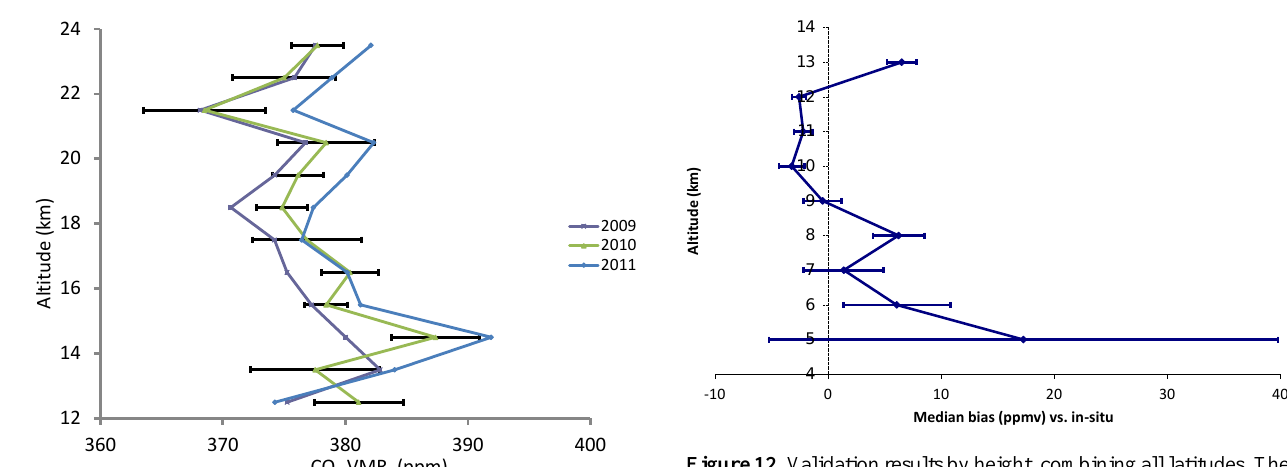
Figure 12. Validation results by height, combining all latitudes. The error bar is the standard error of the bias. Sample sizes ( N) are > 20 in the 7–13km range.